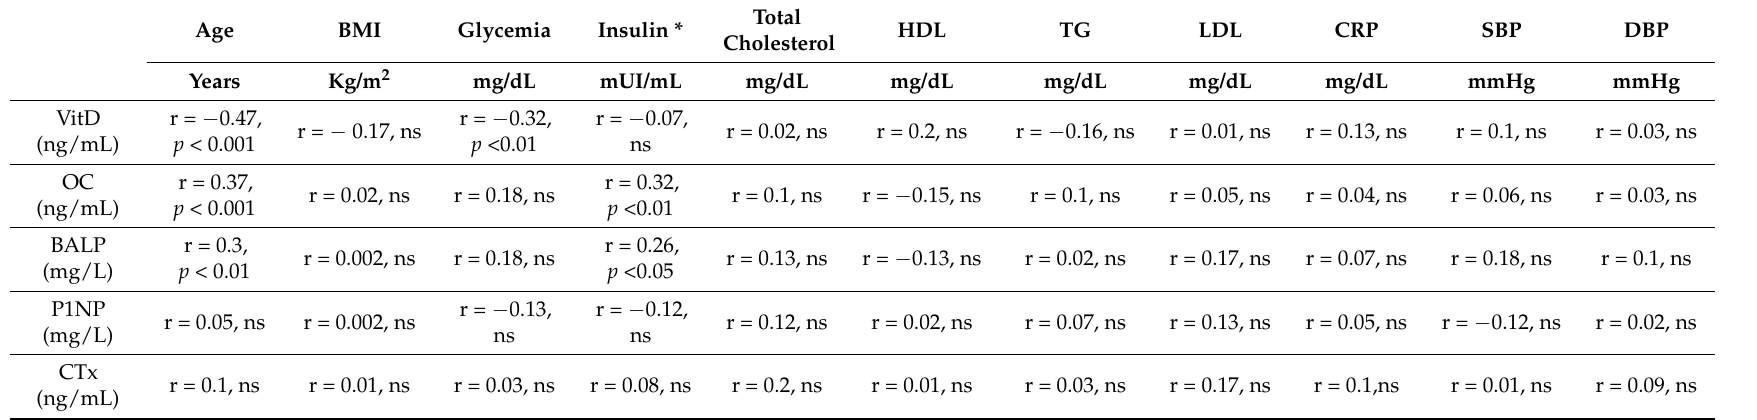
Table 3. Correlation between HBM and continuos